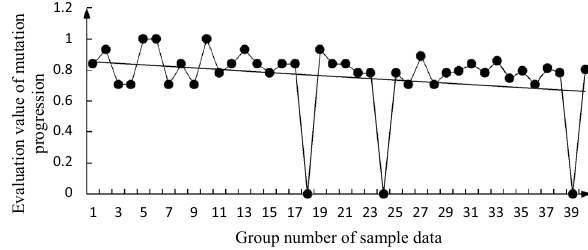
Figure 5. Change trend graph for x F 4 .